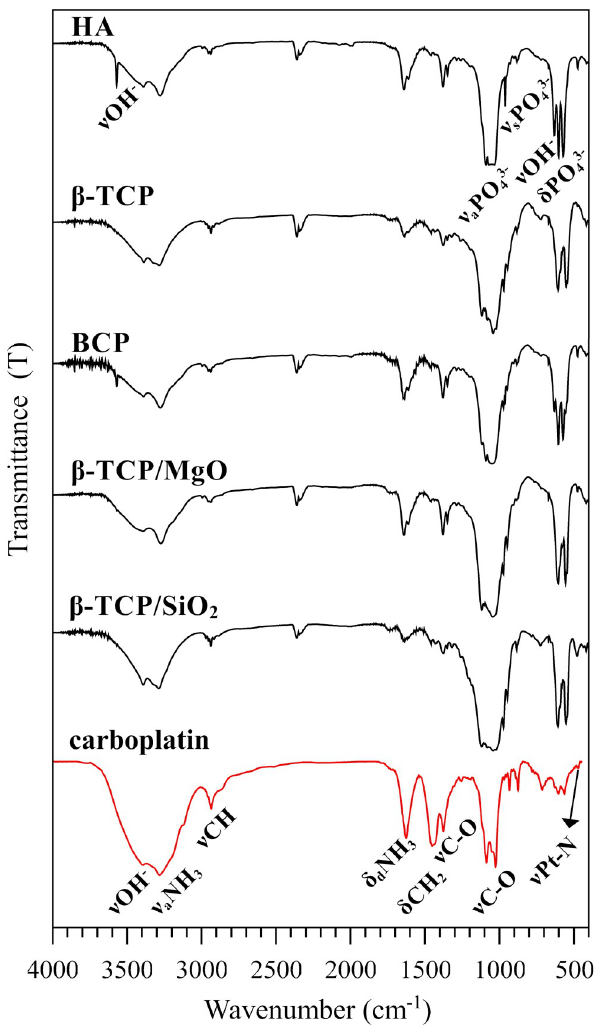
Fig 5. Fourier transform infrared analysis of the biomaterials after the drug loading. FTIR analysis of the 70 mg/g carboplatin-biomaterials compared with carboplatin drug alone (carboplatin and mannitol).